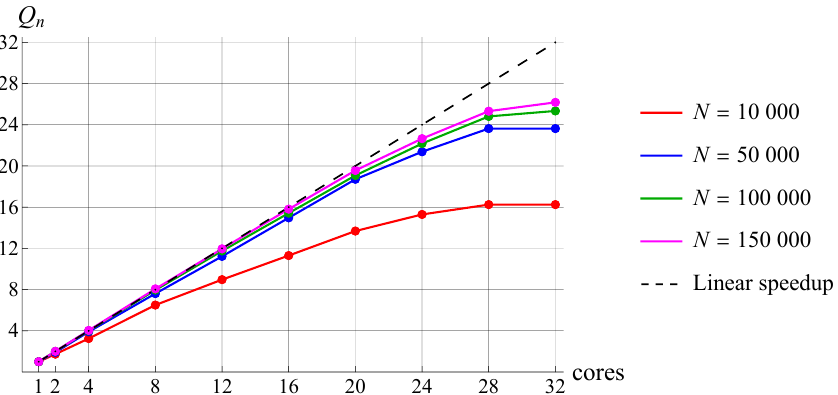
Figure 21. Speedup for different number of cores with OpenMP technology for flow simulation with different resolution; N is the approximate number of vortex particles in the wake.